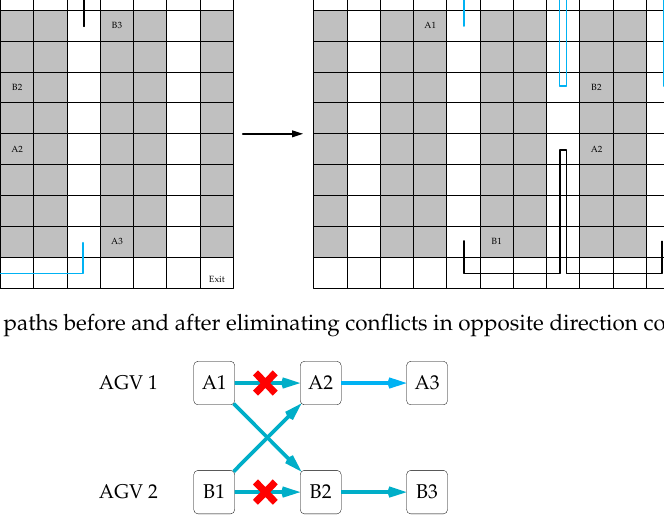
Figure 4. Pickup points sequences before and after eliminating conflicts in opposite direction conflict.